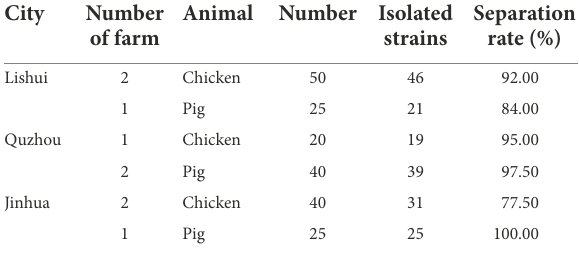
TABLE 1 Source of 200 samples and isolation of 181 E. coli